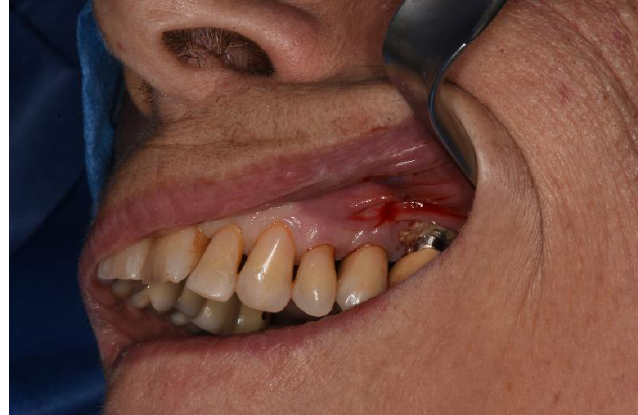
Figure 2 Clinical view.